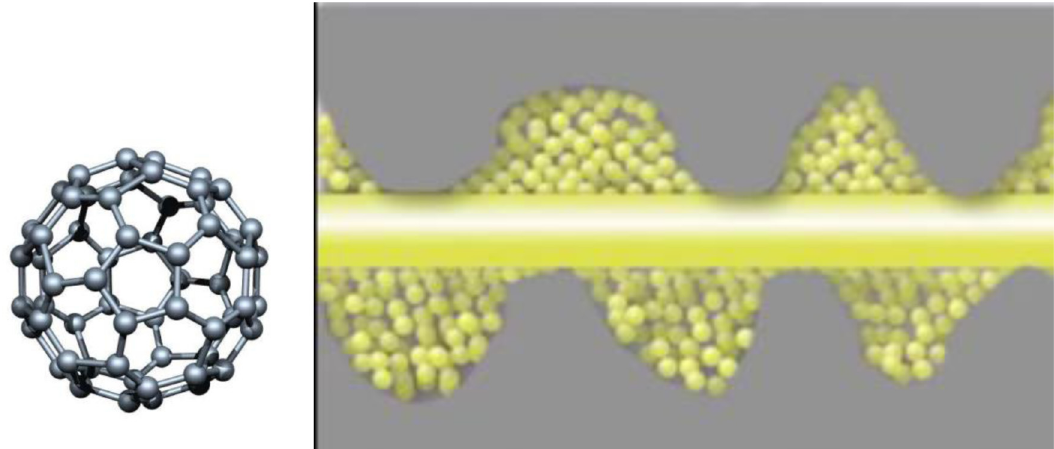
Fig. 1. Representation of a rough contact lubricated by a fl uid with fullerene-like